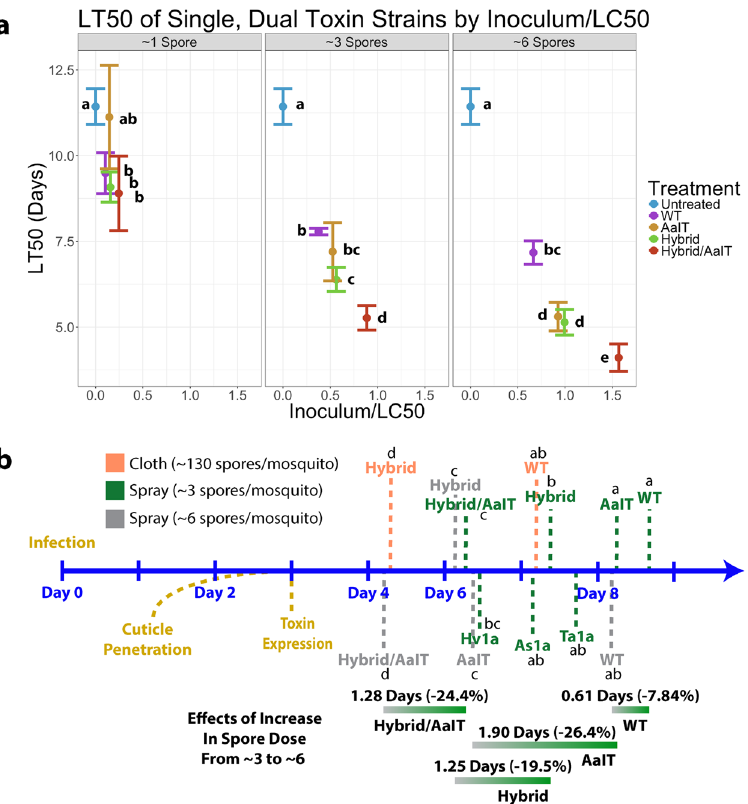
Figure 1. ( a ) LT50 values for mosquitoes treated with 1 × 10 5 , 1 × 10 6 and 1 × 10 7 M. pingshaense conidia/ml suspensions resulting in ~1, ~3 and ~6 conidia/mosquito, respectively, of M. pingshaense WT or M. pingshaense expressing Hybrid, AaIT or both AaIT and Hybrid. LC50 values are reported along the x-axis as the inverse of the estimated spore inoculum. Lettering represents statistical differences (p < 0.05) based on a log-rank test comparing the Kaplan-Meier survival curves. The LC50 dose for untreated mosquitoes was fixed at zero and reported for all spore concentrations for comparison. ( b ) Schematic representing infection timing (beige) and LT50s of mosquitoes treated with conidial suspensions and exposed to cloth impregnated with toxin expressing strains or WT. Lettering groups toxins by statistical significance (p < 0.05) based on a log-rank test comparing the Kaplan-Meier survival